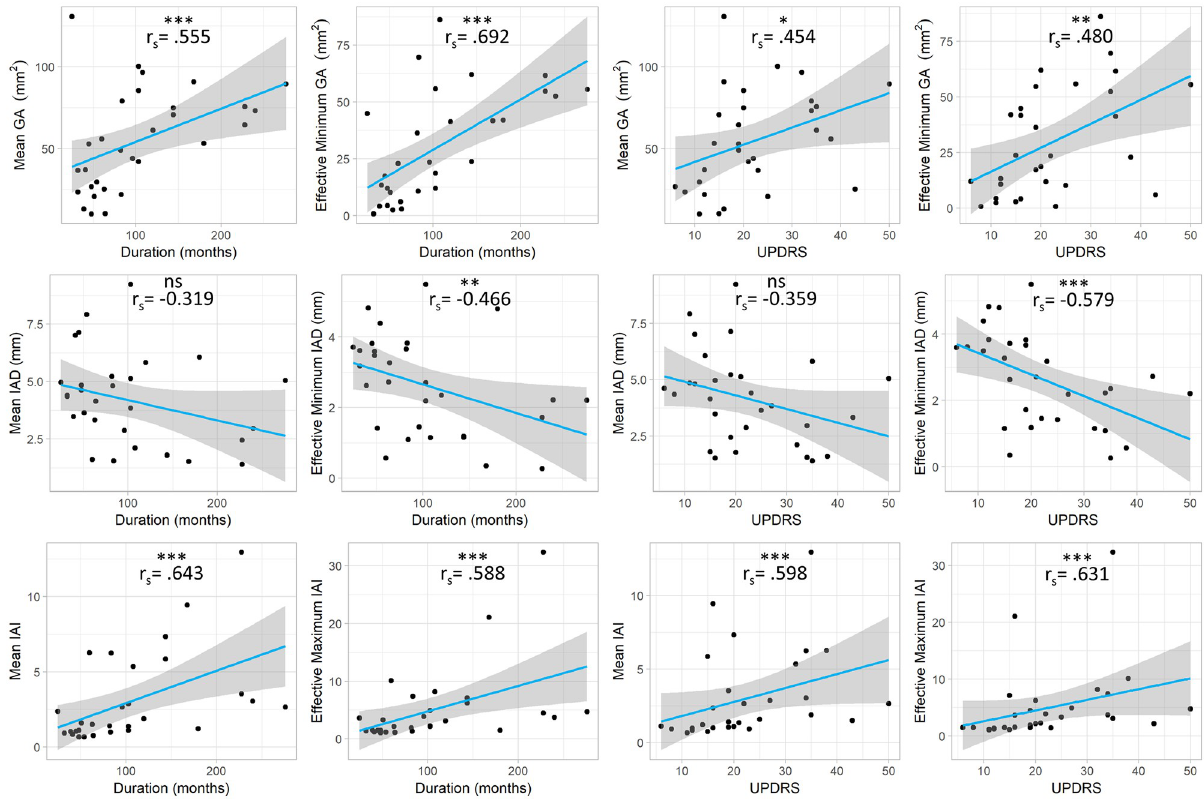
Fig 3. Change in laryngeal measures with disease duration and UPDRS part III scores. Plots of the raw data of the laryngeal measures against duration in months and UPDRS part-III scores. The linear regression ‘line of best fit’ is marked in blue, with the 95% confidence interval shaded in grey. Spearman correlation coefficients (r s ) between the laryngeal measures and disease duration or UPDRS are annotated for each. ns p > 0.05; � p < 0.05; �� p < 0.01; ��� p < 0.001.